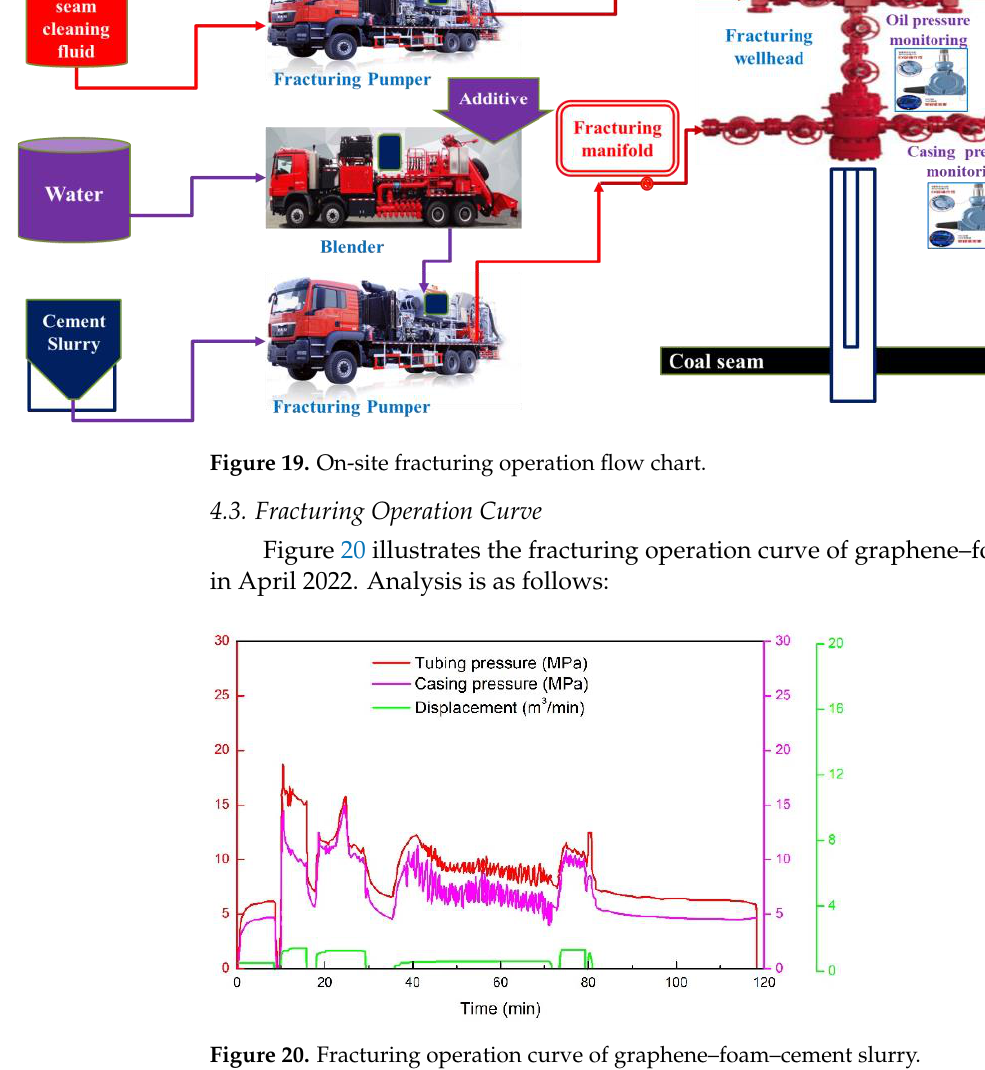
Figure 20. Fracturing operation curve of graphene – foam – cement slurry.